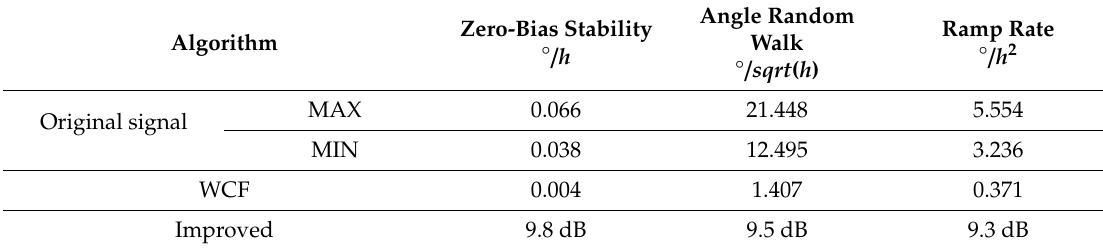
Figure 7. Optimization results of yaw angle (sky) error. Table 3. Optimization results of yaw angle (sky) error.